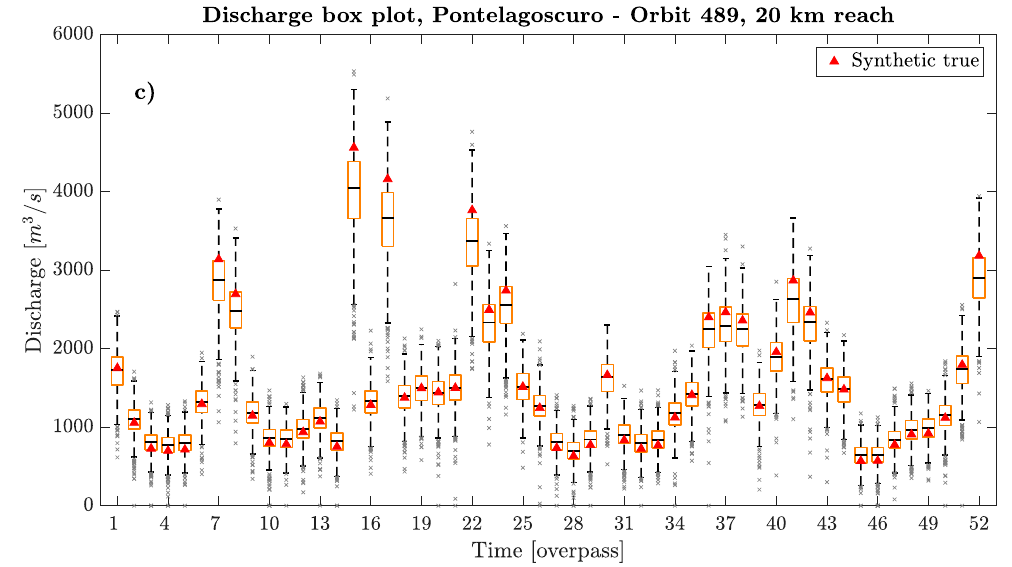
Figure 7. Boxplots of SWOT-based discharges compared with ones provided by the model (synthetic true; red triangle) at the gauging stations of ( a ) Sermide, ( b ) Ficarolo, and ( c ) Pontelagoscuro, as sensed by orbit 489 and considering Δ x equal to 20 km.